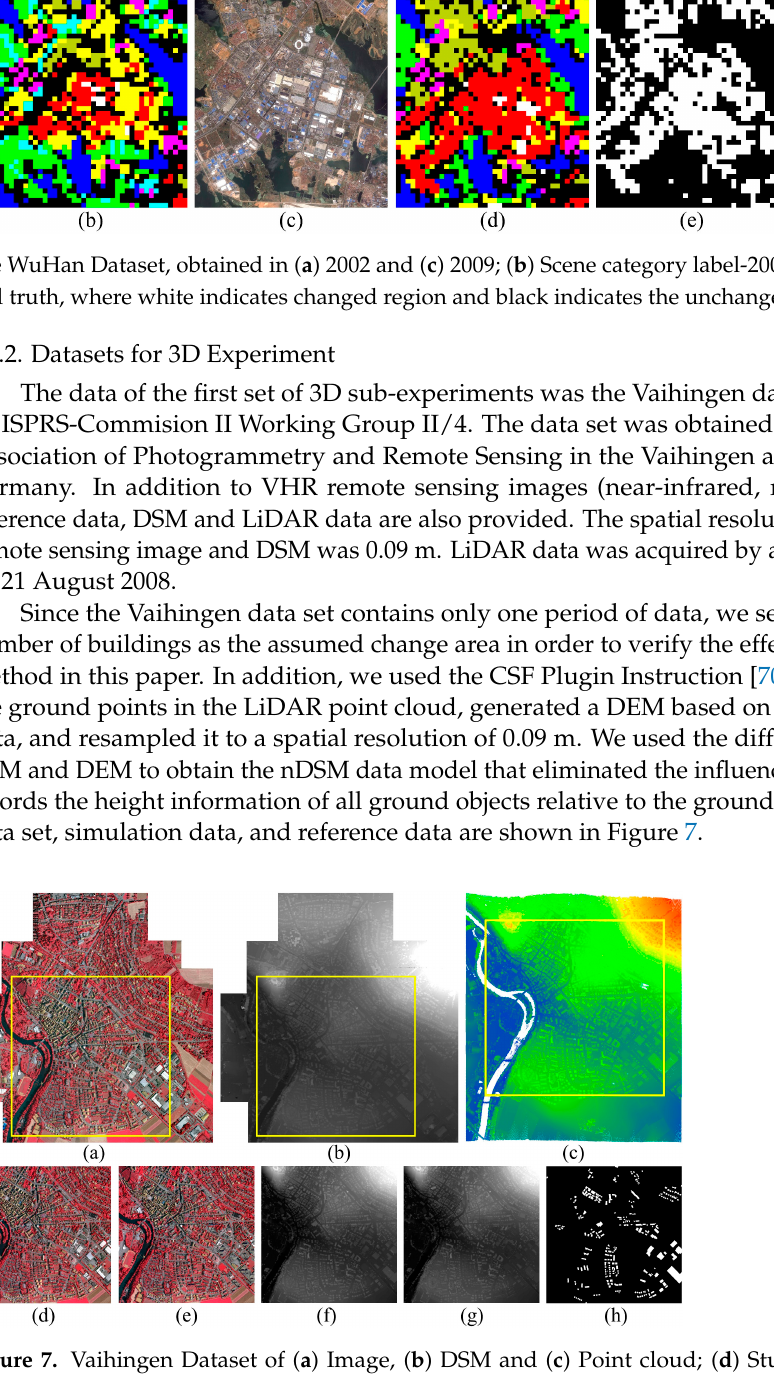
13 of 26 Figure 5. Building change detection dataset, obtained in ( a ) 2012 and ( b ) 2016; ( c ) Study area-2012; ( d ) Study area-2016; ( e ) Ground truth, where white indicates changed region and black indicates the unchanged region. The data of the second group of sub-experiments was the Multi-temporal Scene Wu-